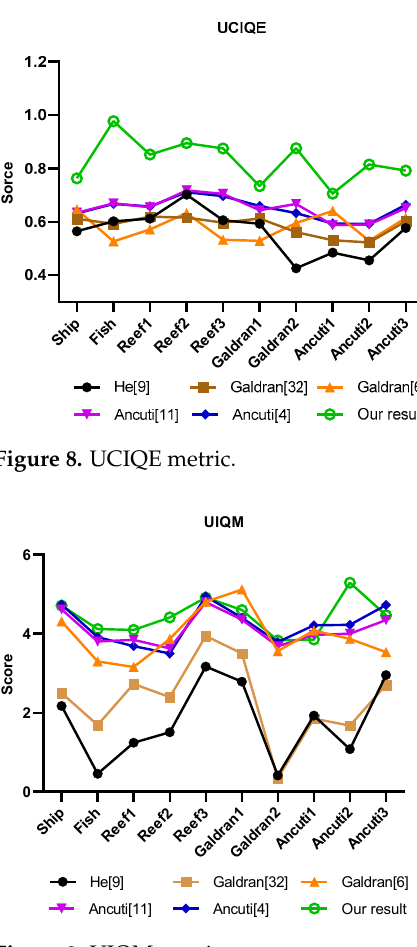
each box graph represent the upper and lower limits of the evaluation metric, respectively, and the green line represents the median of the evaluation metric. No outliers are observed in the evaluation of the UCIQE and UIQM metrics, and the fluctuation is smaller than the other methods. Thus, the proposed method has good performance in underwater images in different